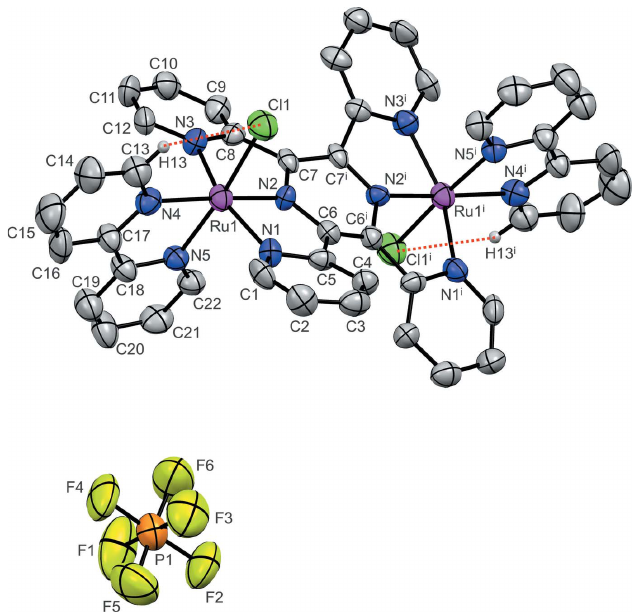
Figure 2 View along the b axis of a 1 (cid:6) 2 (cid:6) 2 crystal packing diagram of I . Displacement ellipsoids are drawn at the 40% probability level. Intra- and intermolecular H (cid:4)(cid:4)(cid:4) Cl interactions (those with separations shorter than the sum of van der Waals radii) are represented by the fine dotted .] 2